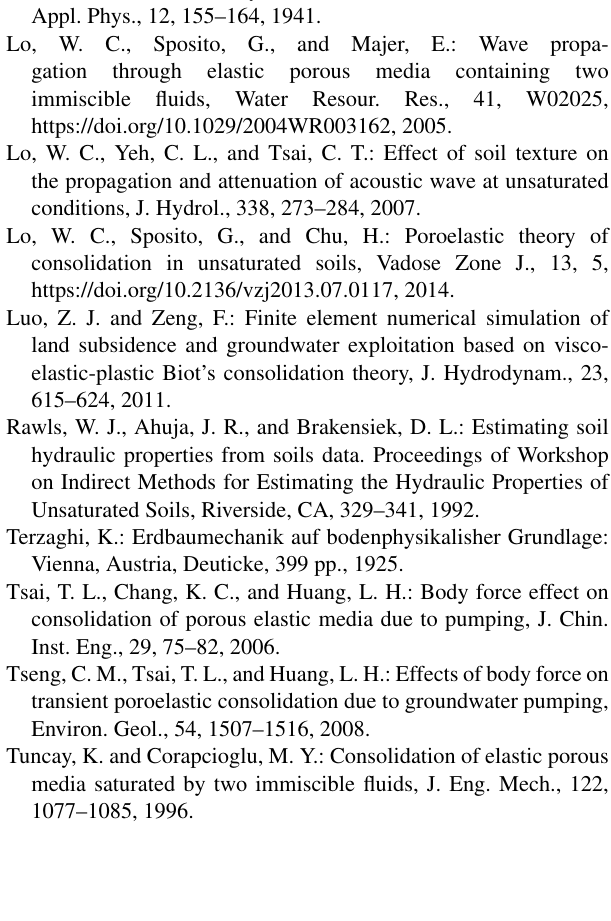
Figure 6. The total settlement caused by fluctuating water level at the top clay boundary versus time (the water table depression at the base of the clay layer is kept constant in time ( h 2 /L = 0 .